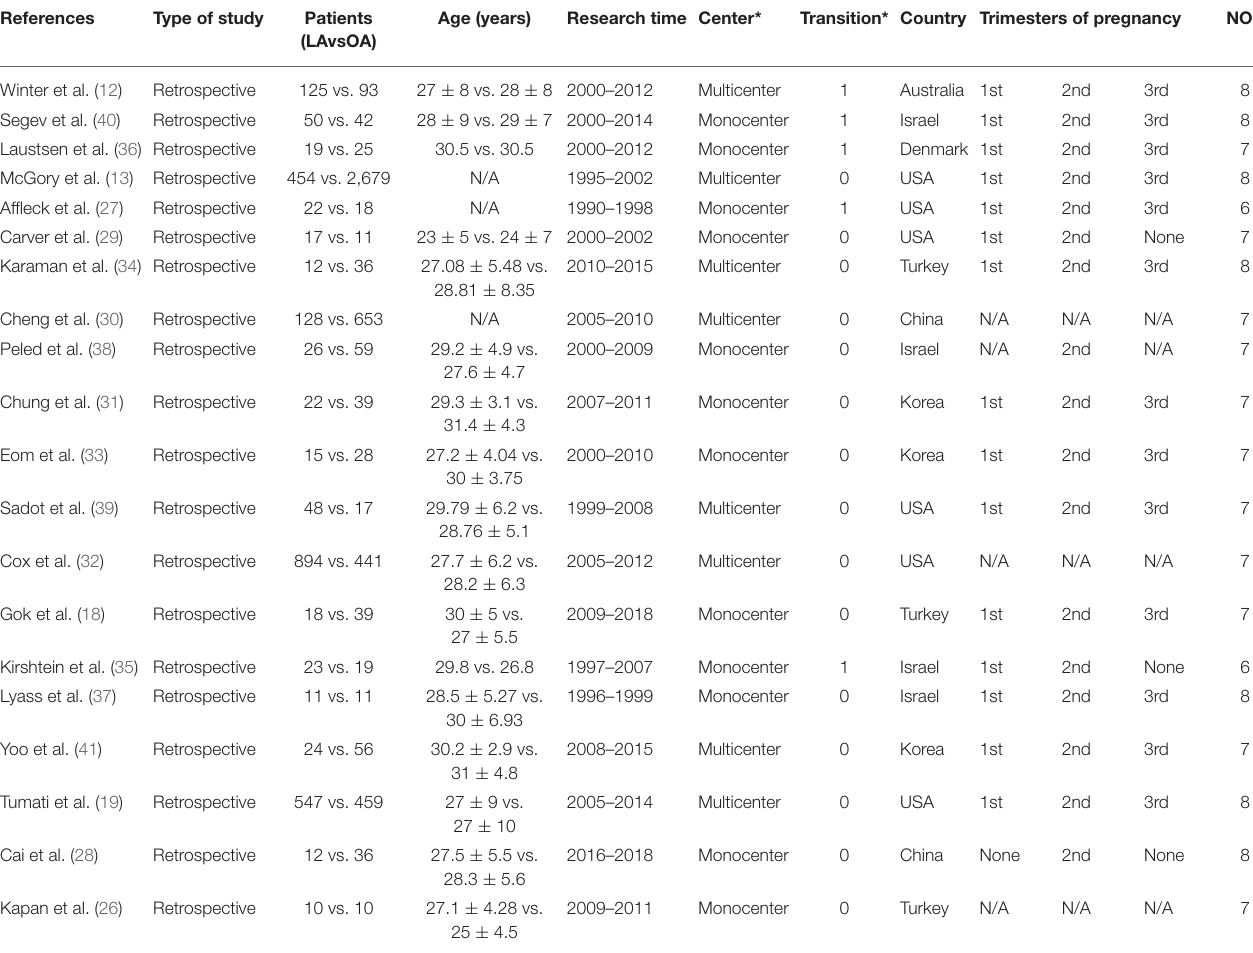
TABLE 1 | Study characteristics and